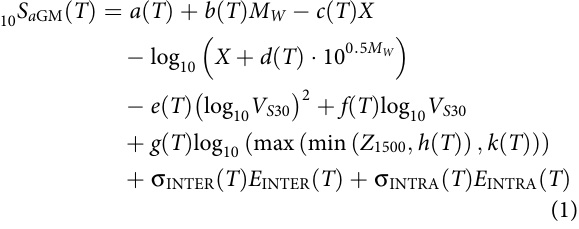
Table2 .Correlationof E INTER ( T )and E INTRA ( T )betweendifferent periods T is important when the possibility of simultaneous damage of multiple items, i.e., a common cause failure, is discussed. The applicable range of the equation is 5.1 (cid:20) M W (cid:20) 6.9, X (cid:20) 100 km, 110 m/s (cid:20) V S 30 (cid:20) 700 m/s, and Z 1500 (cid:20) 3,000 m (Itoi et al.,